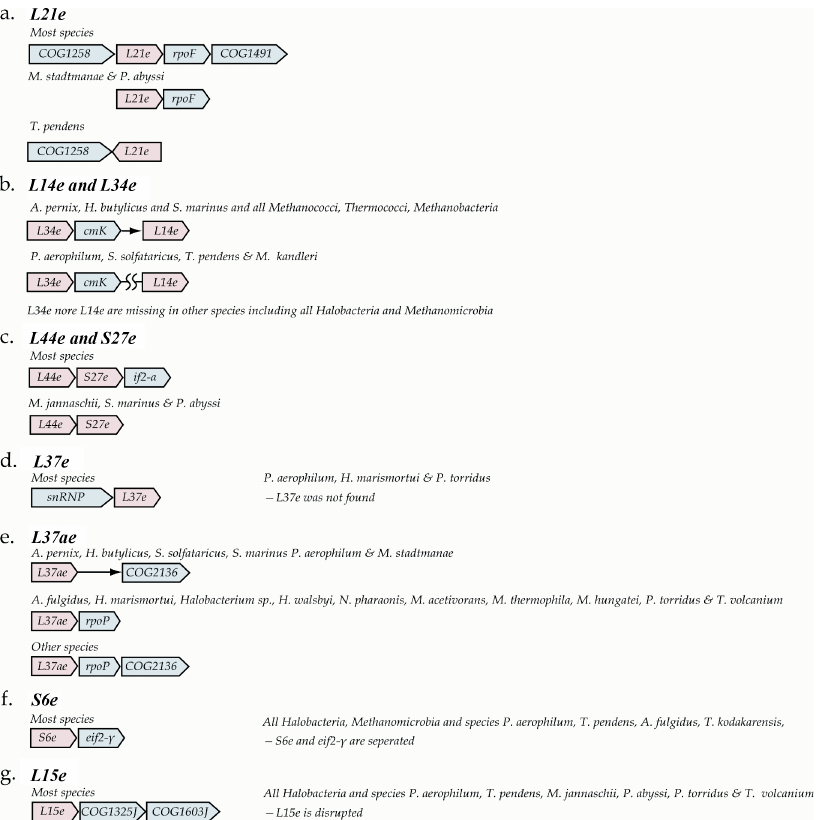
Figure 7. Additional clusters of archaeal unique r-protein genes. Notation is as in Figures 1 and